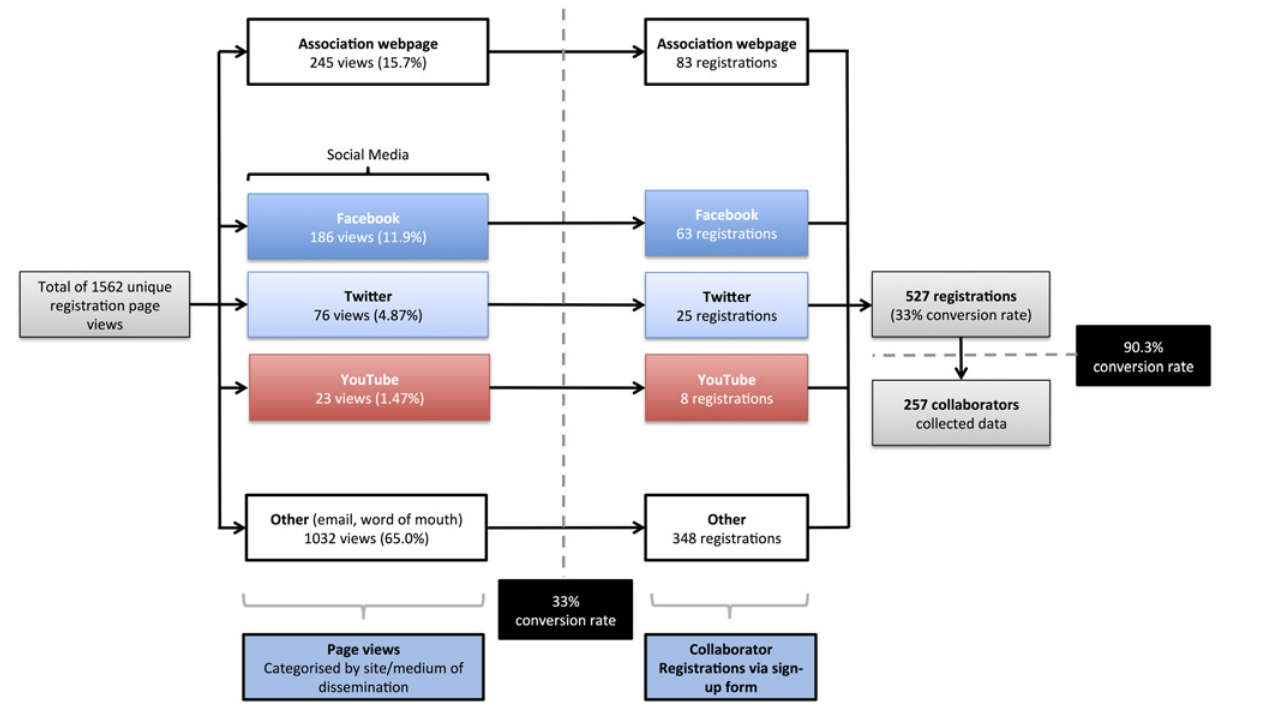
Fig 1. Detailed comparative breakdown of collaborator recruitment by social media and standard